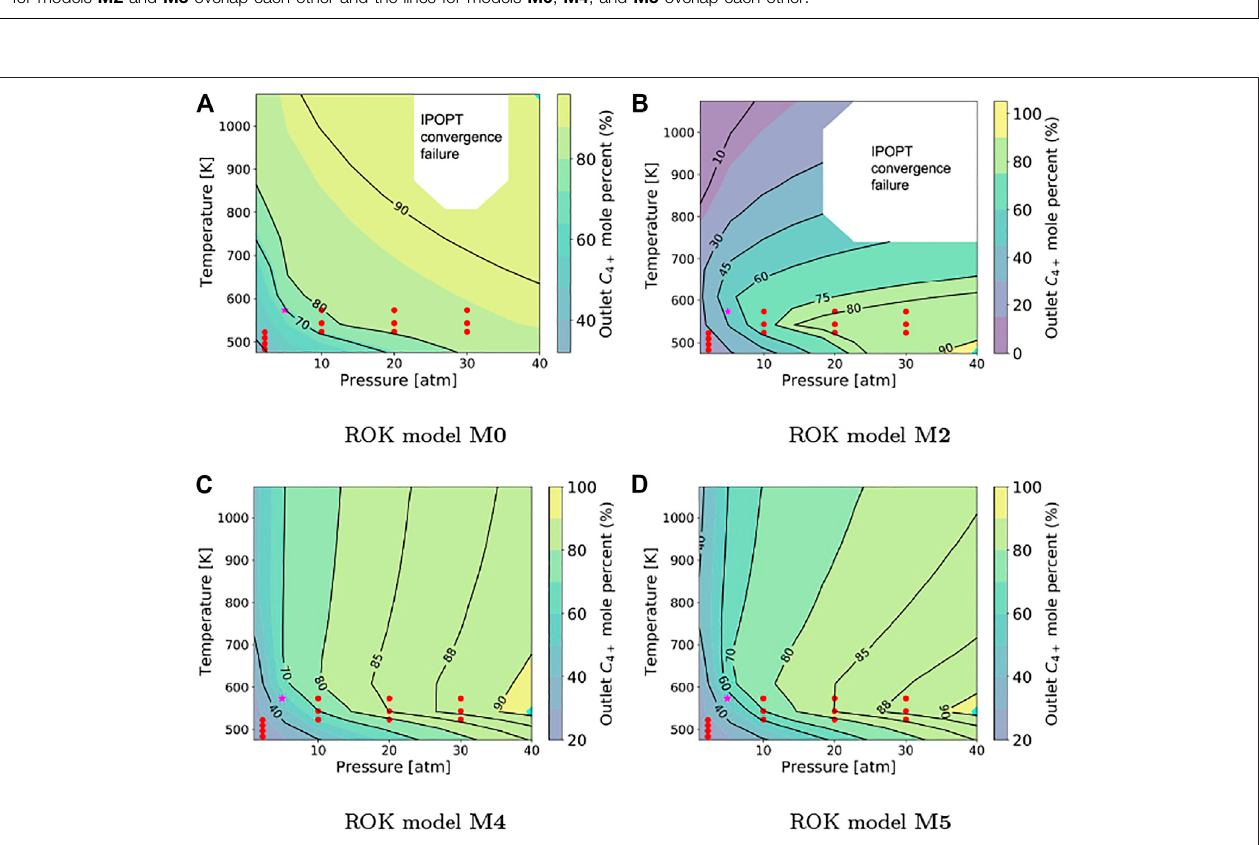
FIGURE 6 | Propylene conversion to butene and heavier ole fi ns between 473 K and 1073 K and 1 atm – 40 atm using (A) M0 , (B) M2 ( M3 has similar countours to M2 ), (C)M4 ,and (D)M5 .ThereddotsrepresentthetemperatureandpressureconditionsatwhichMKdataisavailableandwasusedtotraintheROKmodels(although at different space velocities). The magenta star represents the temperature and pressure conditions suggested by Ridha et al. (2018) for process operations. The cyan- colored diamond representsthe condition for maximum conversion. The white space, aslabeled, represents the operating conditions at which IPOPT isunable to converge the ole fi n material balance for ROK models M0 , M2 , and M3 (similar to M2 but, not shown here).